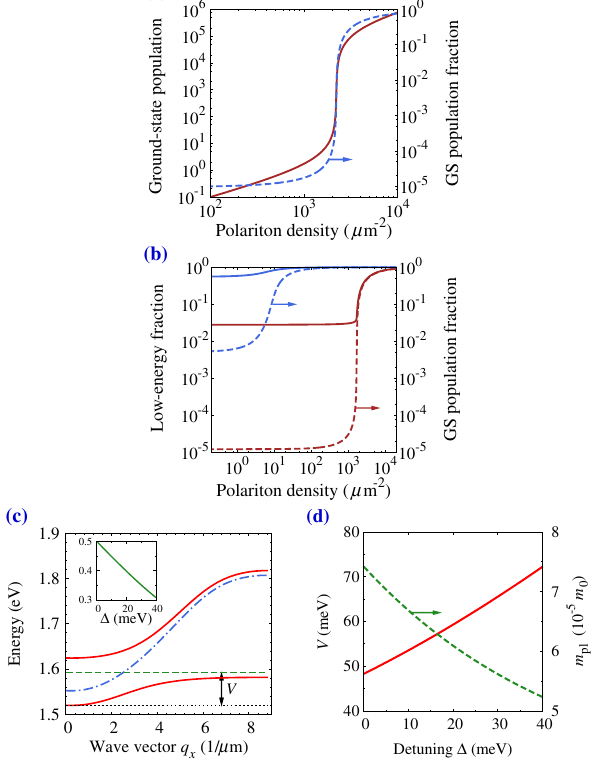
FIG. 4. Polariton population on the ground state and other low-energy states for the exciton-box trap with D ¼ 10 μ m, an exciton-photon coupling of ℏ Ω ¼ 48 meV, and an exciton- ¼ 1 . 59 eV. The QW width is recombination energy of E X 0 4 nm, and the barrier-layer width is 5 nm. The detuning is (a) Δ ¼ 30 meV and (b) Δ ¼ 40 meV. (a) Population of the ground state (GS) vs polariton density (solid curve). The rapid, nonlinear increase of the GS population indicates the BEC transition. The GS population fraction (dashed curve), i.e., the GS population divided by the total population, is of order unity for densities beyond the BEC transition. (b) GS population fraction (dashed curves) and the population fraction on the low-energy discrete states (solid curves) below the continuum . (There are more than 1000 exciton-recombination energy E X 0 such states.) These low-energy states are photonlike states with very small effective mass, whereas states higher than E are X 0 excitonlike. When a large population fraction resides in the photonlike states, the BEC threshold density is reduced. For T ¼ 100 K (blue curves), populated polariton states are mostly photonlike. The threshold density is much lower than for T ¼ 300 K (brown curves), where the population fraction on low-energy states is negligible. (c) The dispersion of polaritons (solid red curves), bare excitons (dashed green curve), and pure photons (dash-dotted blue curve) for detuning Δ ¼ 40 meV with ¼ π =a ¼ 8 . 6 μ m − 1 for a ¼ 370 nm. The dispersion depth of q y the lower polariton branch V is also depicted. (The dotted black line denotes the lower polariton band edge.) Inset: Excitonic fraction of the lower polariton branch as a function of detuning Δ . (d) The dispersion depth V (solid red curve) and polariton (dashed green curve) of the lower polariton effective mass m pl branch vs the detuning Δ